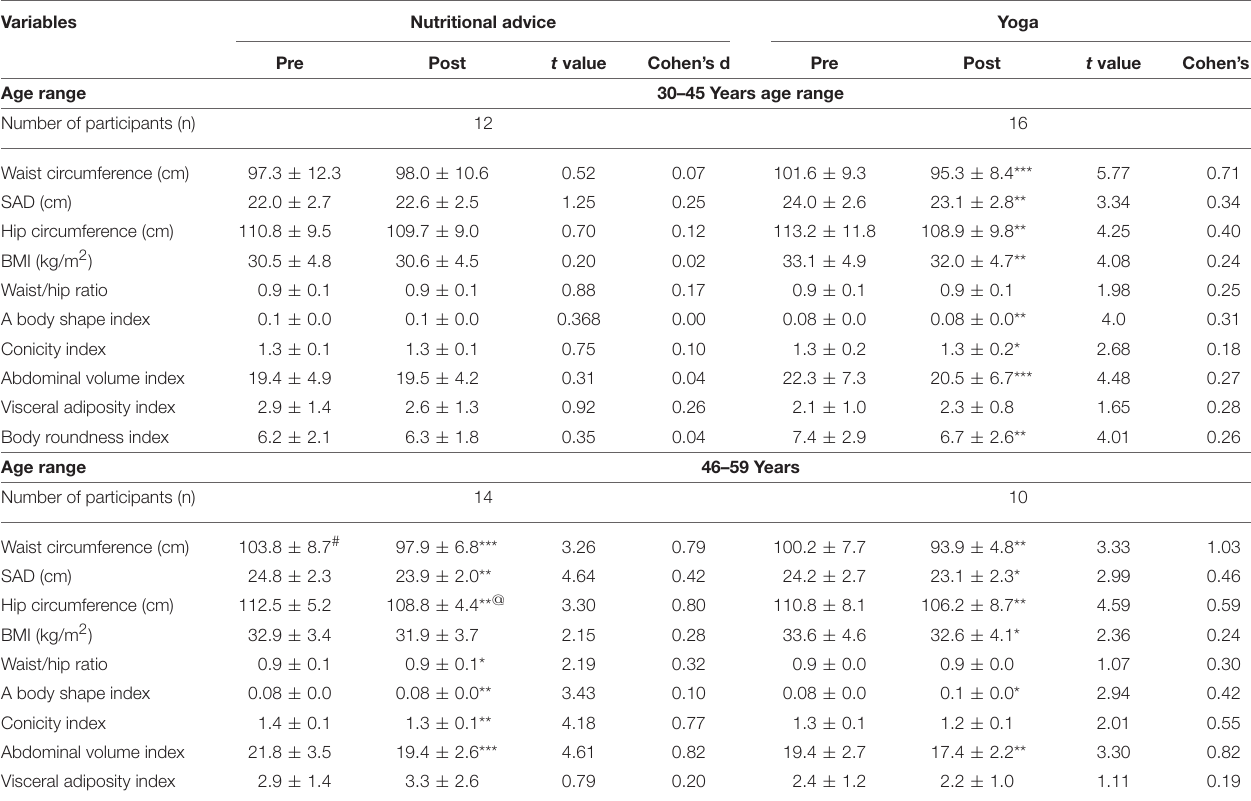
TABLE 8 | Anthropometric variables and derived indices for two age range i.e., 30-45 and 46-59 year. Variables Nutritional